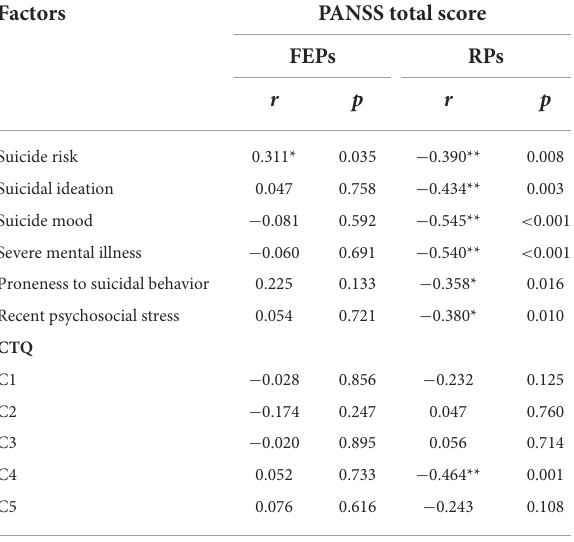
TABLE 5 Correlation analysis between PANSS about suicide-related risks and childhood trauma.